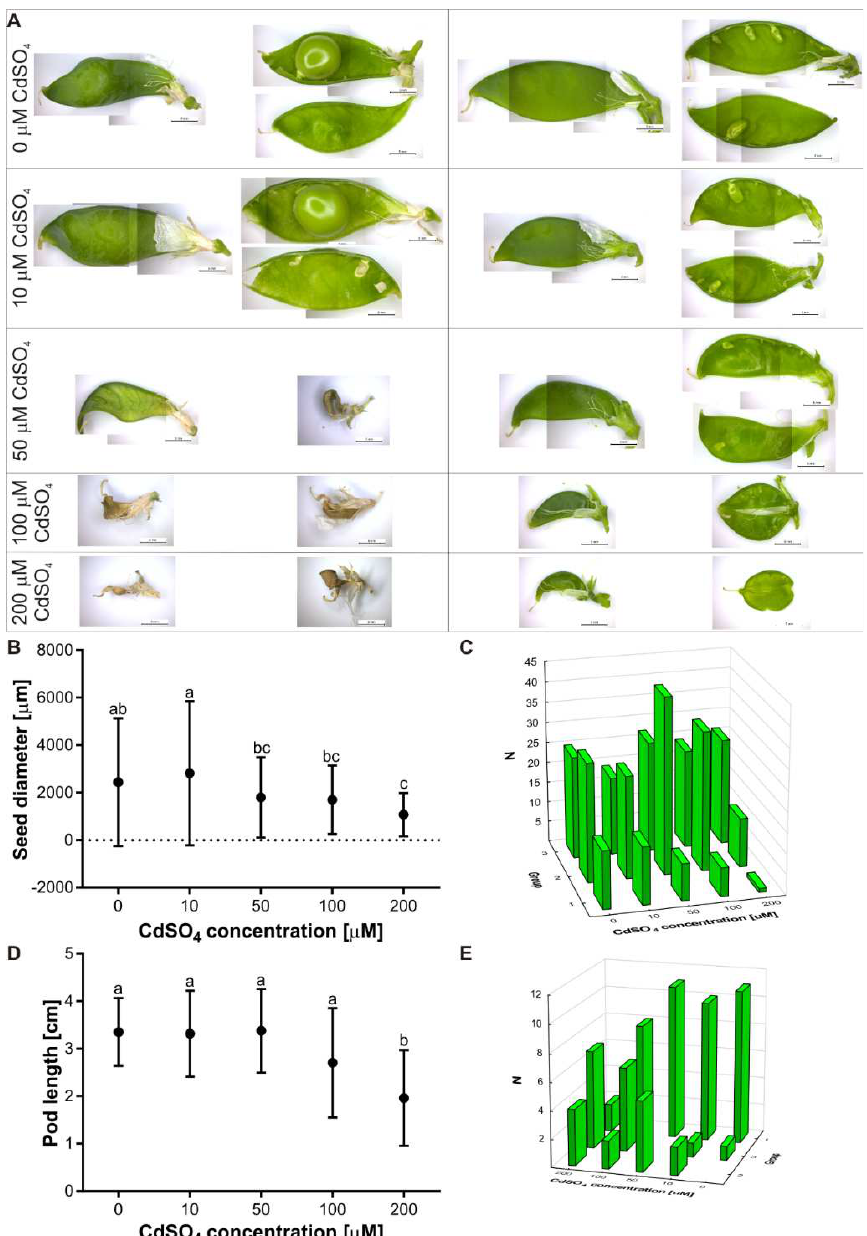
Figure 5. The pod and seed development during the experiment and Cd-treatment. ( A )— Representative images of the pods of the control plants and the plants treated with 10, 50, 100, and 200 µ M CdSO 4 ( A ). The pictures in the left panel show pods developed from flowers formed during the first week after Cd-treatment, whereas the pictures in the right panel show pods developed from flowers formed during the third week of the experiment. ( B , C )—The length ( B ) and distribution ( C ) of seeds in the pea pods after 28 days of Cd-treatment. The distribution of the three groups of seeds (1—the first, 2—the second and 3—the third) after 0, 10, 50, 100 and 200 µ M CdSO 4 treatment ( C ). ( D , E )—The length ( D ) and distribution ( E ) of the pea pods after 28 days of Cd-treatment. The distribution of the three groups of pods (1—the first, 2—the second and 3—the third) after 0, 10, 50, 100 and 200 µ M CdSO 4 treatment ( E ). Each value is the mean of three replicates ± SD. Different letters represent significant differences ( p < 0.05). Sale bar: 5